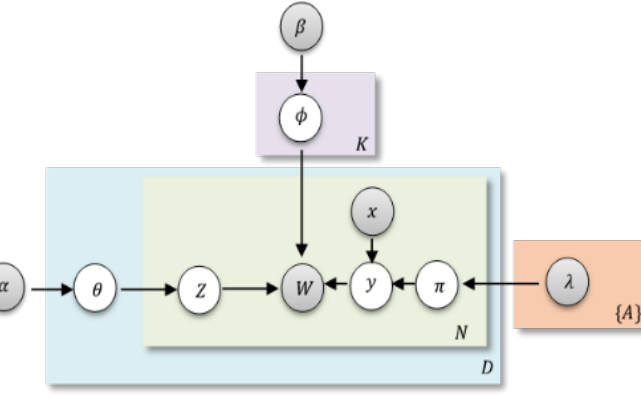
Figure 2. The proposed model in plate notation.